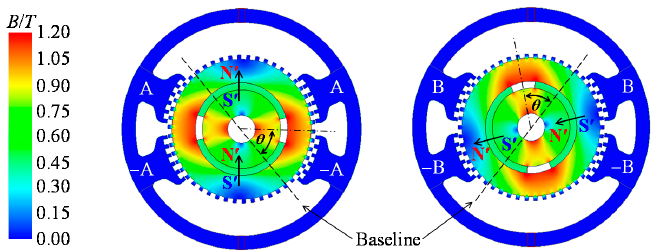
Figure 10. Magnetic field distribution of the accurate 2-D equivalent motor model of sub-motor1 at θ = 49.5° produced by the rotor PMs.